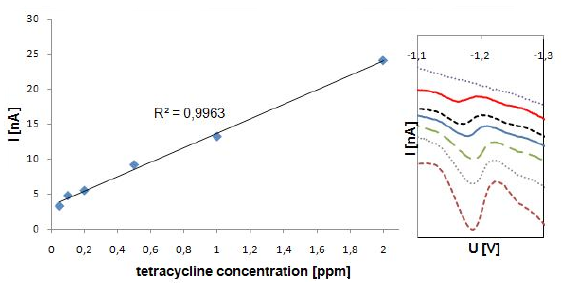
Figure 6. Photocatalytic setup.